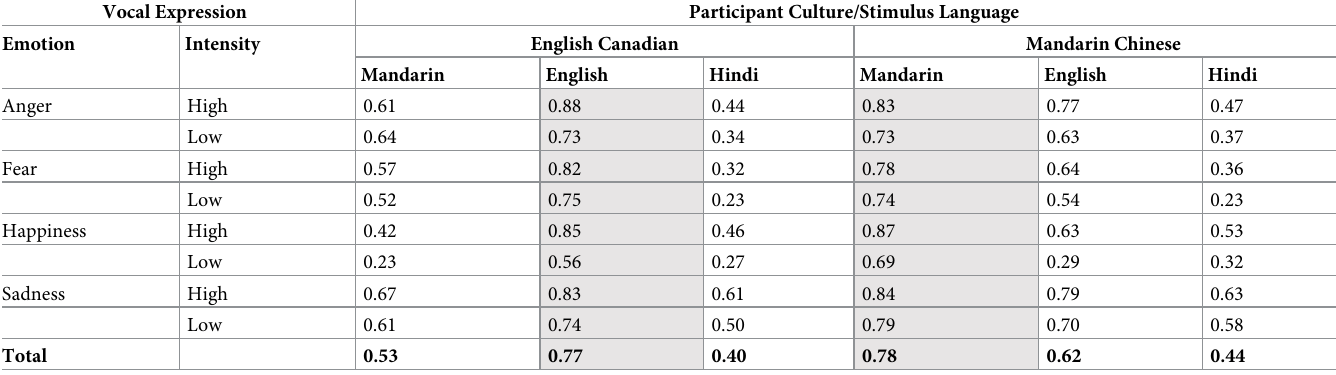
Shaded cells refer to the ‘in-group’ condition for each participant